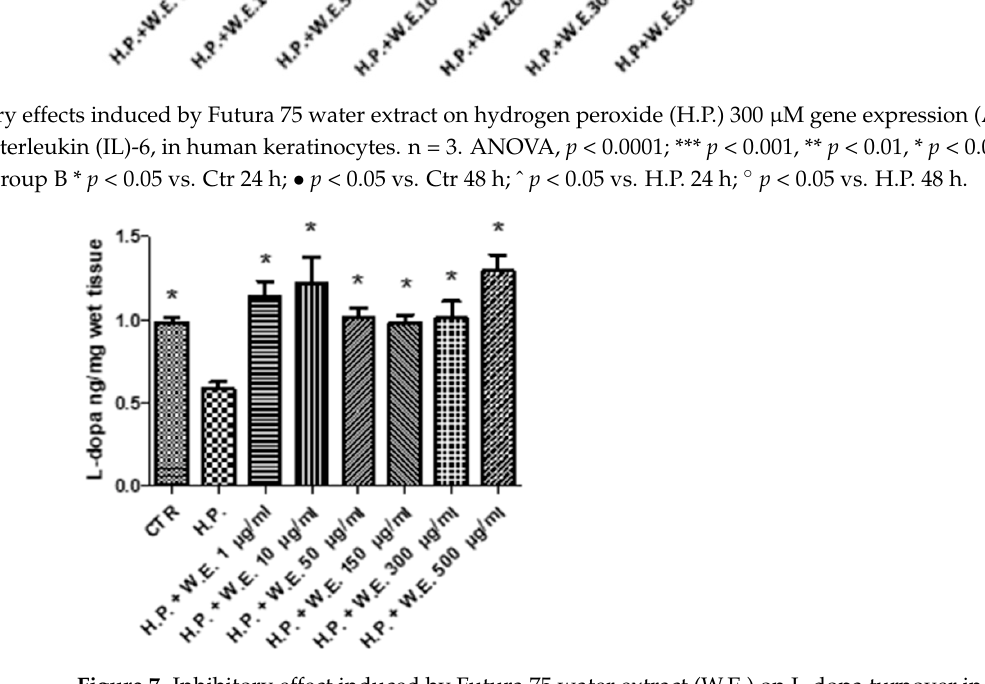
Figure 8. Inhibitory effect induced by Futura 75 water extract (W.E.) on prostaglandin (PG)E 2 production increased by hydrogen peroxide (H.P.) 1 mM, in isolated mouse skin specimens. ANOVA, P<0.01; **P<0.01, *P<0.05 vs. H.P.